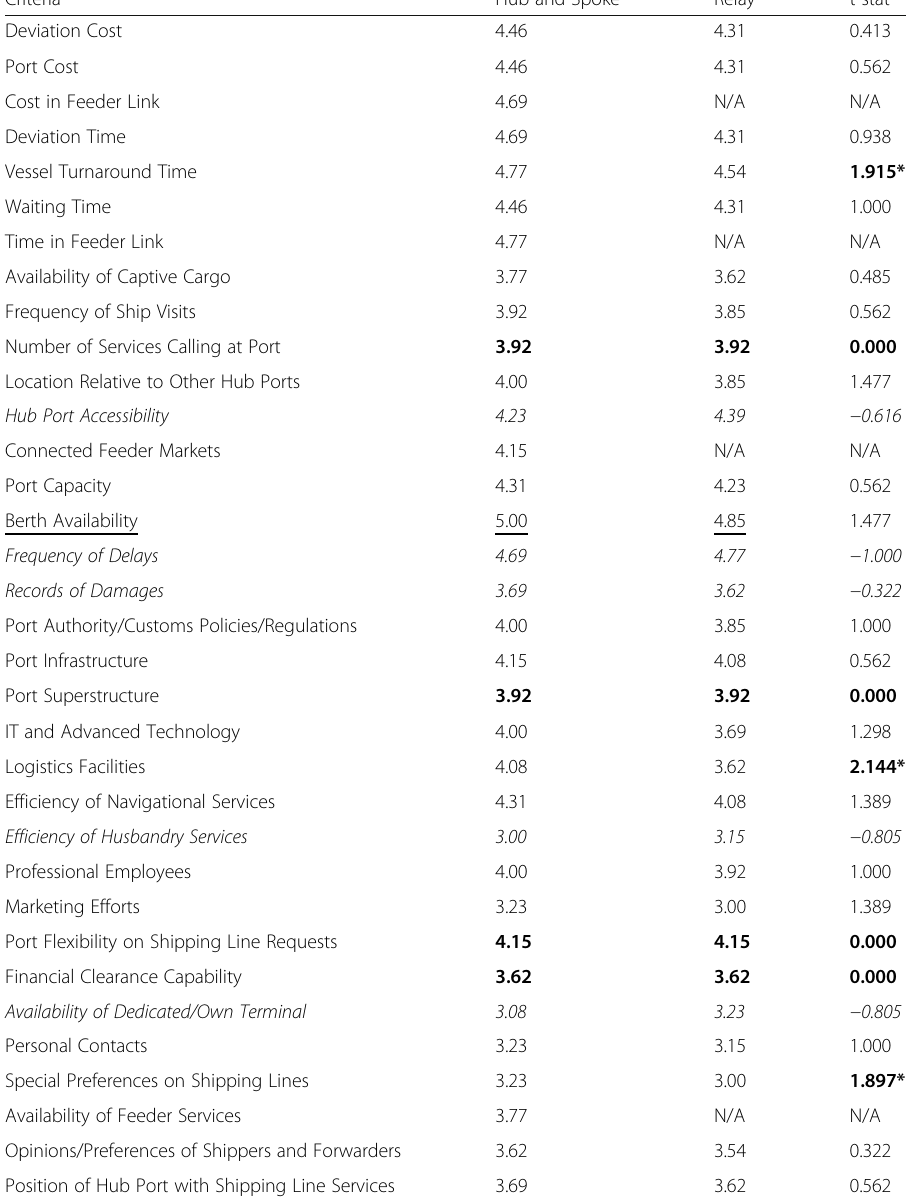
Table 10 Average Significance Scores (AvSSs) of the Criteria